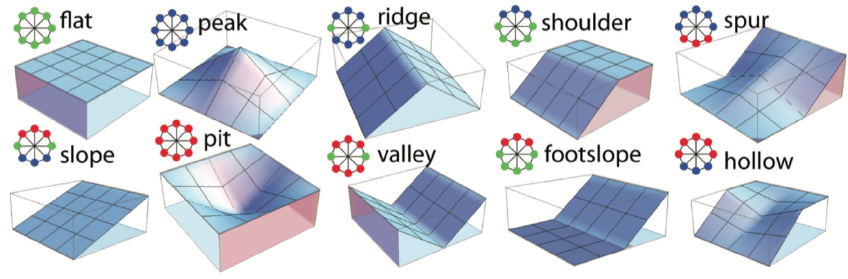
Figure 4. Terrain features represented in r.geomorphon (J. Jasiewicz, T. St˛epi´nski, 2012). The rose diagrams for each feature are colored based on the difference in height with the central cell as reference (green: same height, red: higher, blue: